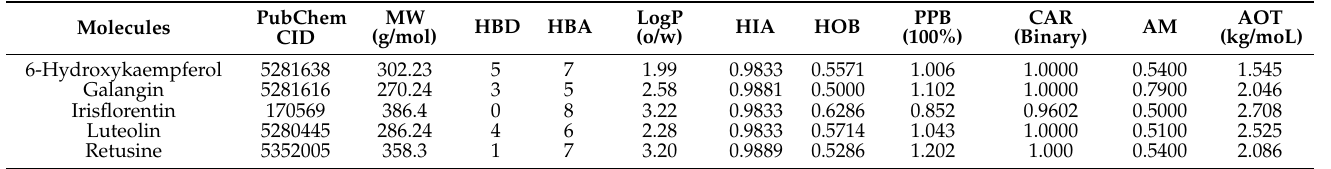
Table 8. Absorption, digestion, metabolism, excretion, and toxicological (ADME/T) properties of the compounds for good oral